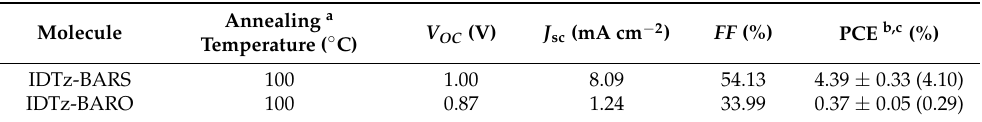
Figure 4. J – V curves of PTB7-Th:IDTz-BARO, PTB7-Th:IDTz-BARS and PTB7-Th. Table 2. Optimized photovoltaic performances of OPVs under illumination of AM 1.5 G irradiation (100 mW cm − 2 ).